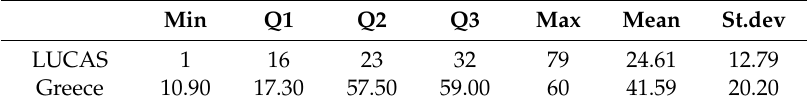
Figure 2. ( a ) Satellite image acquired by MSI Sentinel-2 sensor of the study site in Northern Greece along with the distribution of sampling points (cyan); ( b ) soil association map based on Food and Agriculture Organization (FAO) soil codes; and ( c ) the location and extent of the study area. Table 2. Summary statistics of clay (%) for the selected mineral cropland soil samples of the LUCAS 2009 topsoil database and for the local dataset in Greece. Q1, Q2, and Q3 denote the first, second and third quartile,